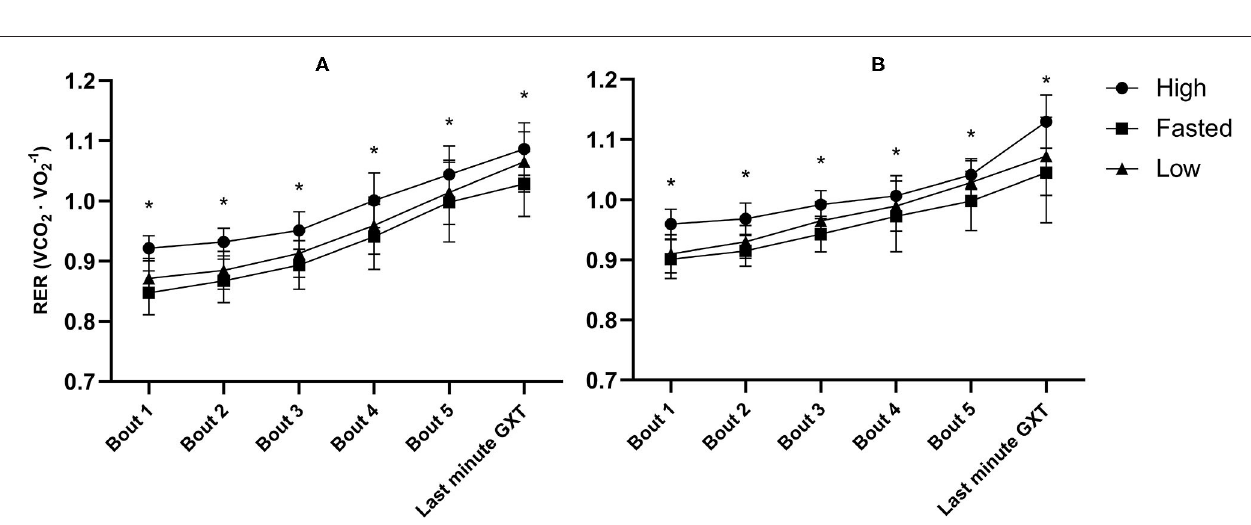
FIGURE 3 | Mean blood lactate concentrations before and after warm-up, following all five 5-min exercise bouts at ∼ 50, 60, 70, 80, and 90% of ˙VO 2max , and after the graded exercise test (GXT) in well-trained (A) and recreationally trained (B) . High, pre-event meal with high carbohydrate content; low, pre-event meal with low carbohydrate content; fasted, test in fasted state. *significant effect of pre-event meals after a follow-up test with both groups included ( p ≤ 0.05).